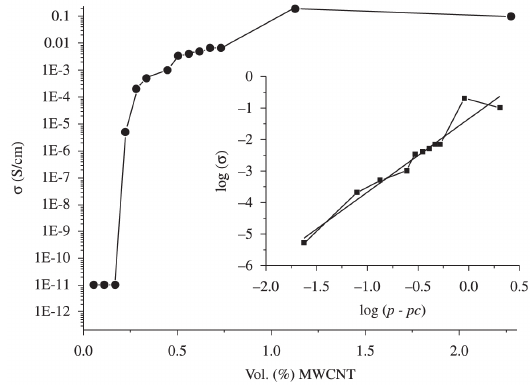
Figure 1. Volumetric electrical conductivity as a function of MWCNT concentration for MWCNT/PMMA